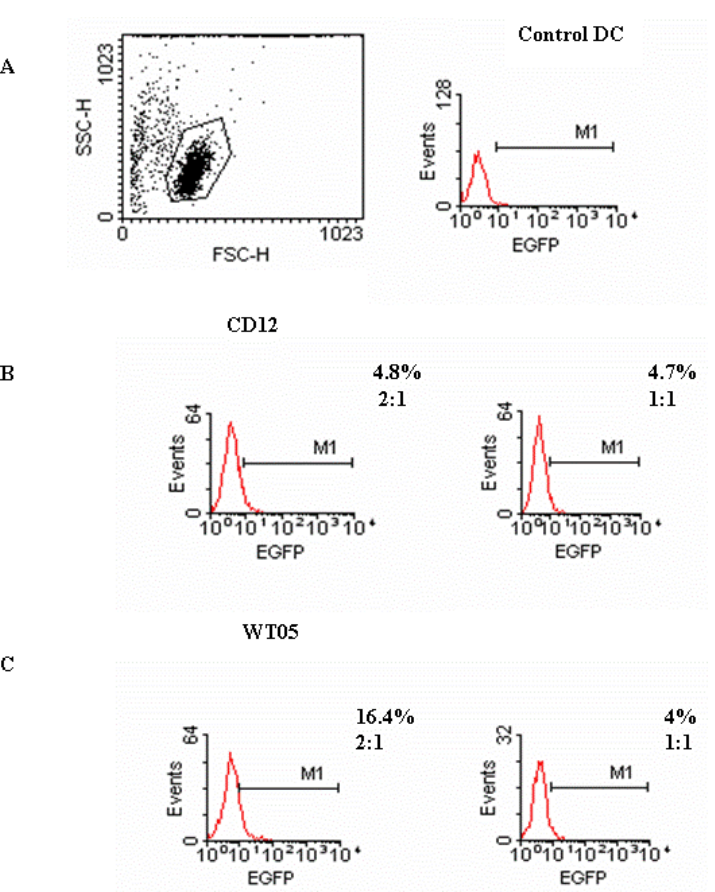
FIGURE 3. Graphs representing expression of EGFP in DC infected with S. typhimurium strains CD12 and WT05 as demonstrated by flow cytometry. Panel A shows the dot-plot graph with viable DC gated, as well as uninfected DC that were the negative control. Panel B represents EGFP expression by DC infected with CD12 at the MOI of 2:1 and 1:1, and panel C shows strain WT05. The figures above the histograms show the percentage of cells expressing EGFP as compared to negative